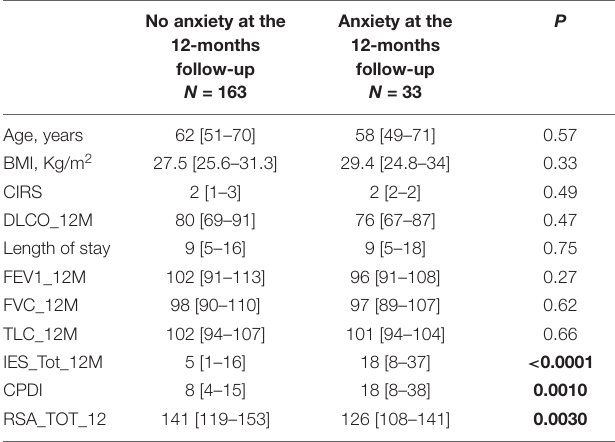
TABLE 1 | Comparison of independent samples.